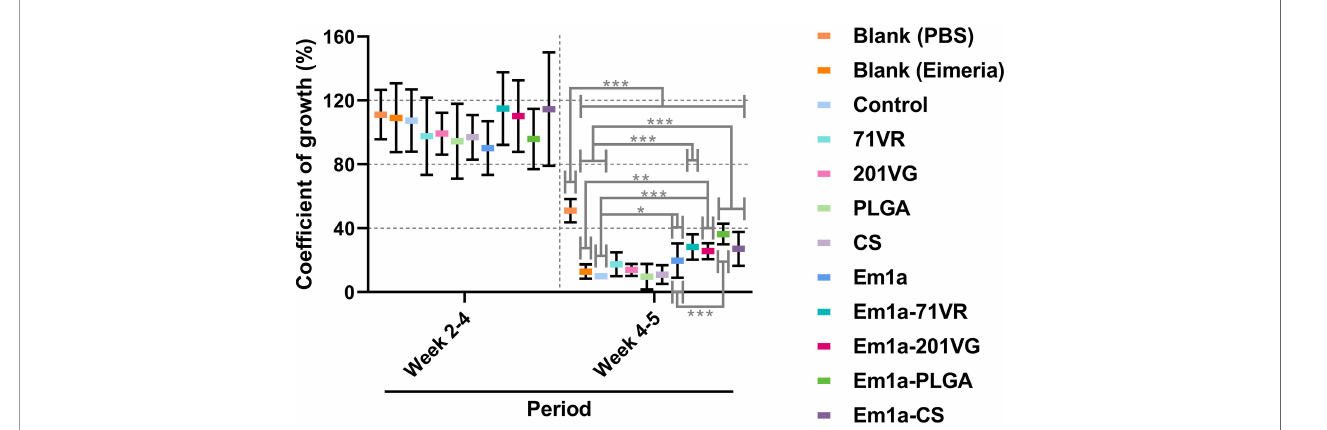
FIGURE 10 | The coef fi cient of growth in vaccinated chickens. Each animal was orally challenged with 5 × 10 4 puri fi ed E. mitis oocysts 1 week after the booster immunization. Animals were weighed at the age of 2 weeks (before the fi rst immunization), 4 weeks (1 week after the booster immunization), and 5 weeks (1 week after the challenge), and the coef fi cient of growth was calculated. Each animal was measured once, and values were estimated using one-way ANOVA followed by Dunnett ’ s test. Comparisons among Em1a, Em1a-71VR, Em1a-201VG, Em1a-PLGA, and Em1a-CS group were conducted by ANOVA following Bonferroni ’ s correction. Values were presented as the mean ± SD (n = 10). In all studies, * p < 0.05, ** p < 0.01, and *** p < 0.001.